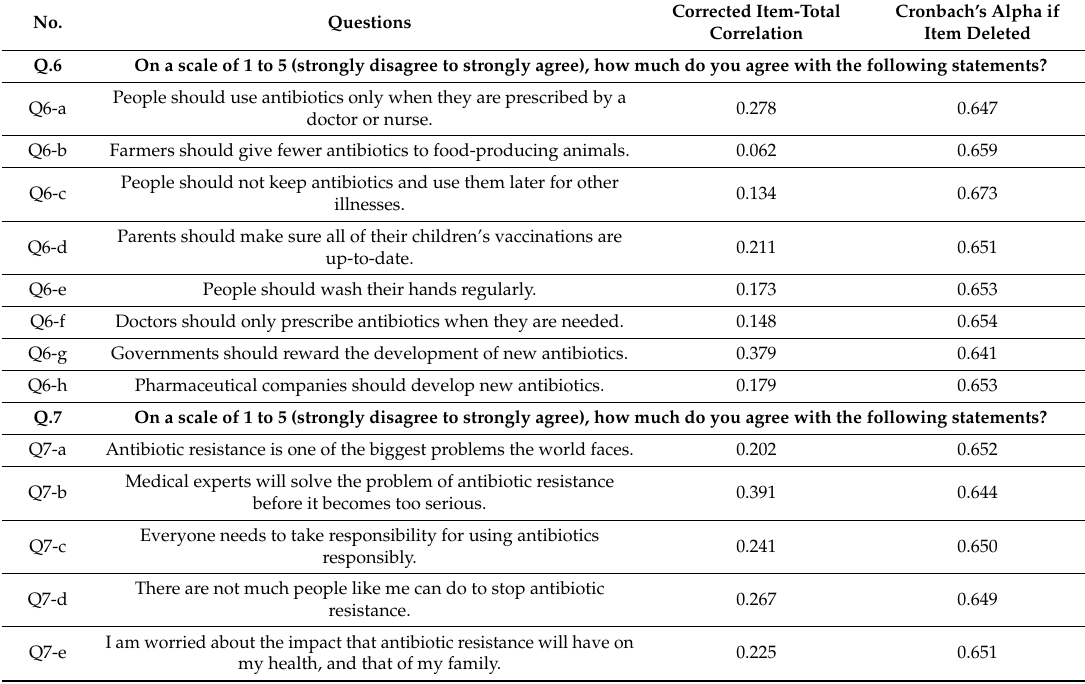
Table 6. Reliability test results for knowledge and understanding about antibiotic use and antibiotic